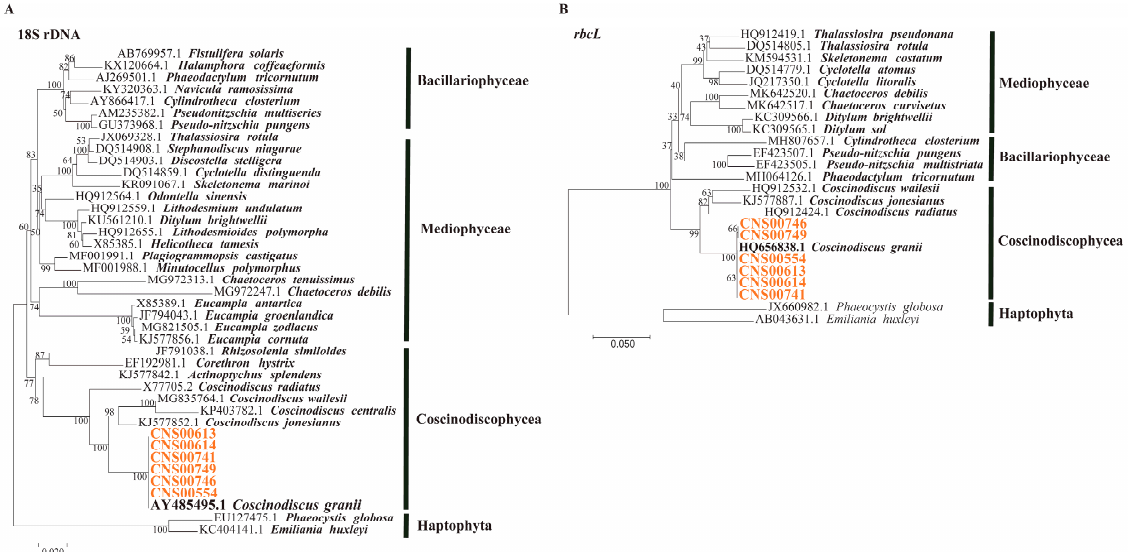
Figure 3. Identification of six strains of C. granii . ( A , B ): ML Phylogenetic trees based on the marker 18S rDNA and rbcL, respectively.